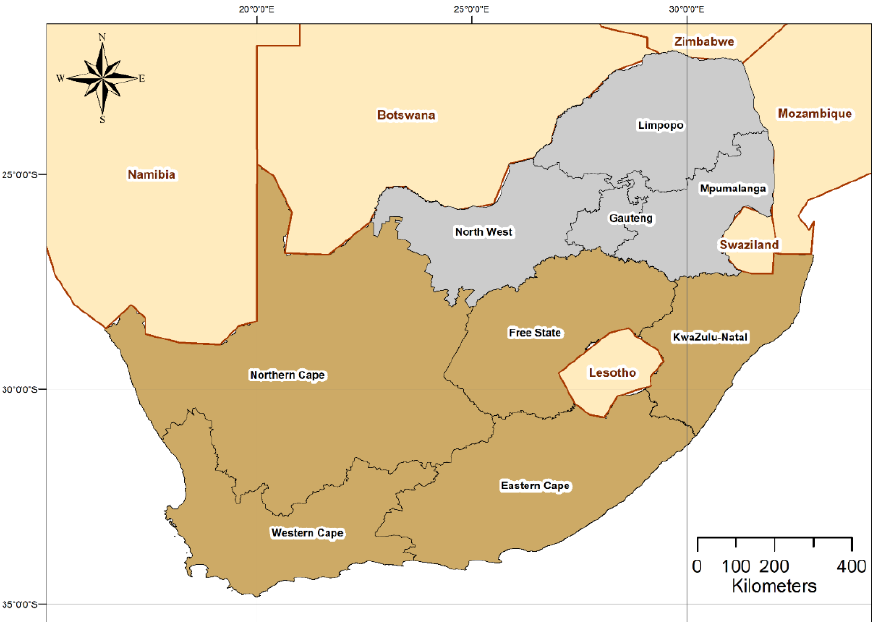
Figure 1. Map of South Africa indicating the provinces and major cities. The provinces for which data were applied in the analyses in this study are shaded in grey. Research ethics clearance for the study was granted by the University of Pretoria (102/2011) and permissions to use the dataset were in